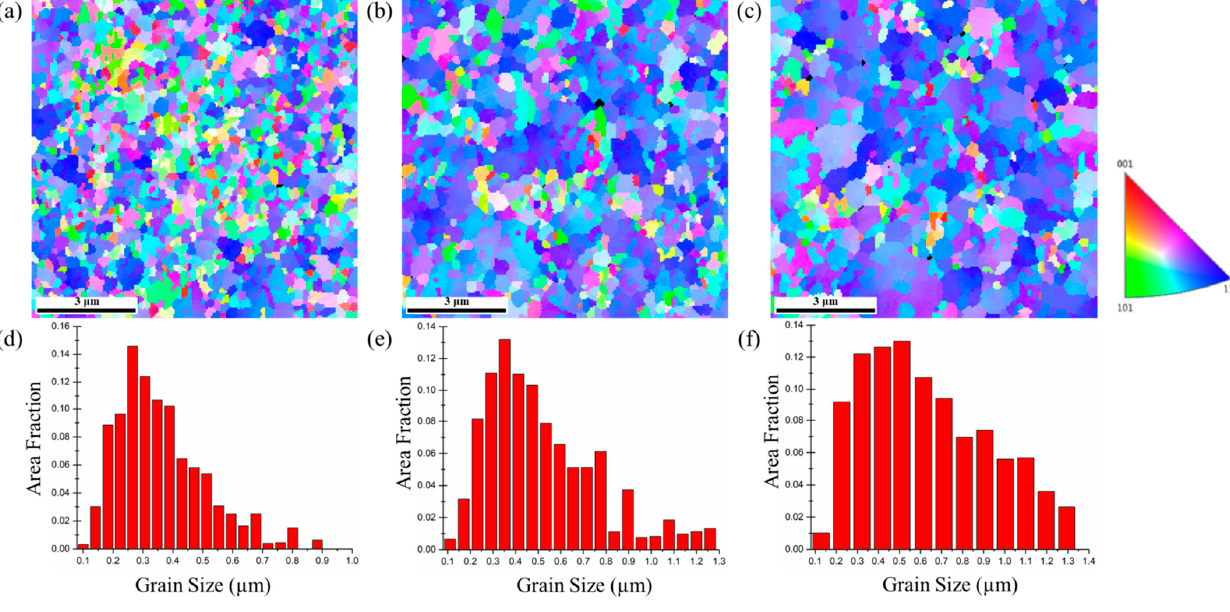
Figure 7. Plan-view EBSD micrographs and grain size distributions of the 15- μ m thick nt-Cu foils electroplated with different concentrations of Cu 2+ : ( a , d ) 0.3 M; ( b , e ) 0.5 M; ( c , f ) 0.8 M, respectively. Table 1. Grain size of the nt-Cu foils obtained using plan-view EBSD